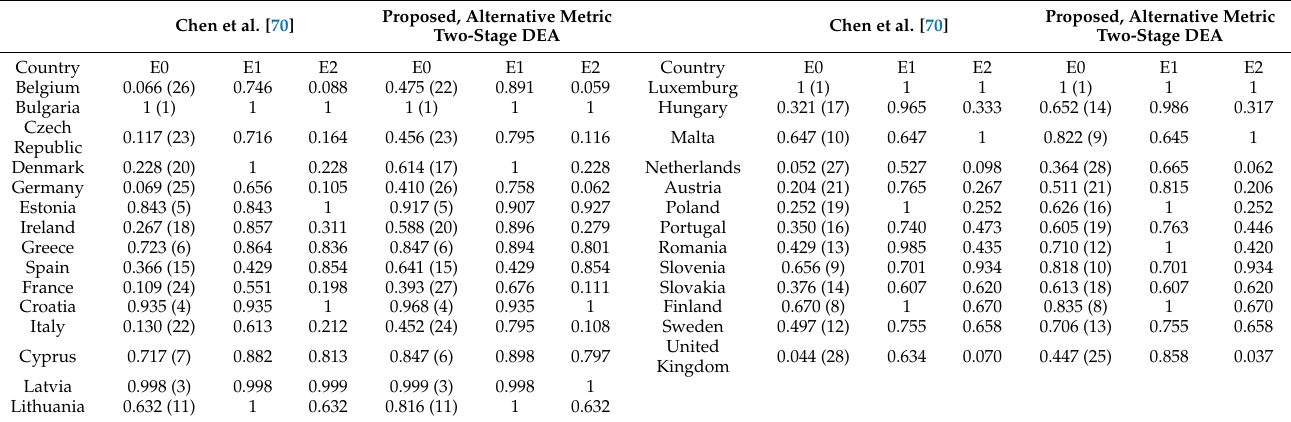
Table 2. Another set of results from the two variations with additional